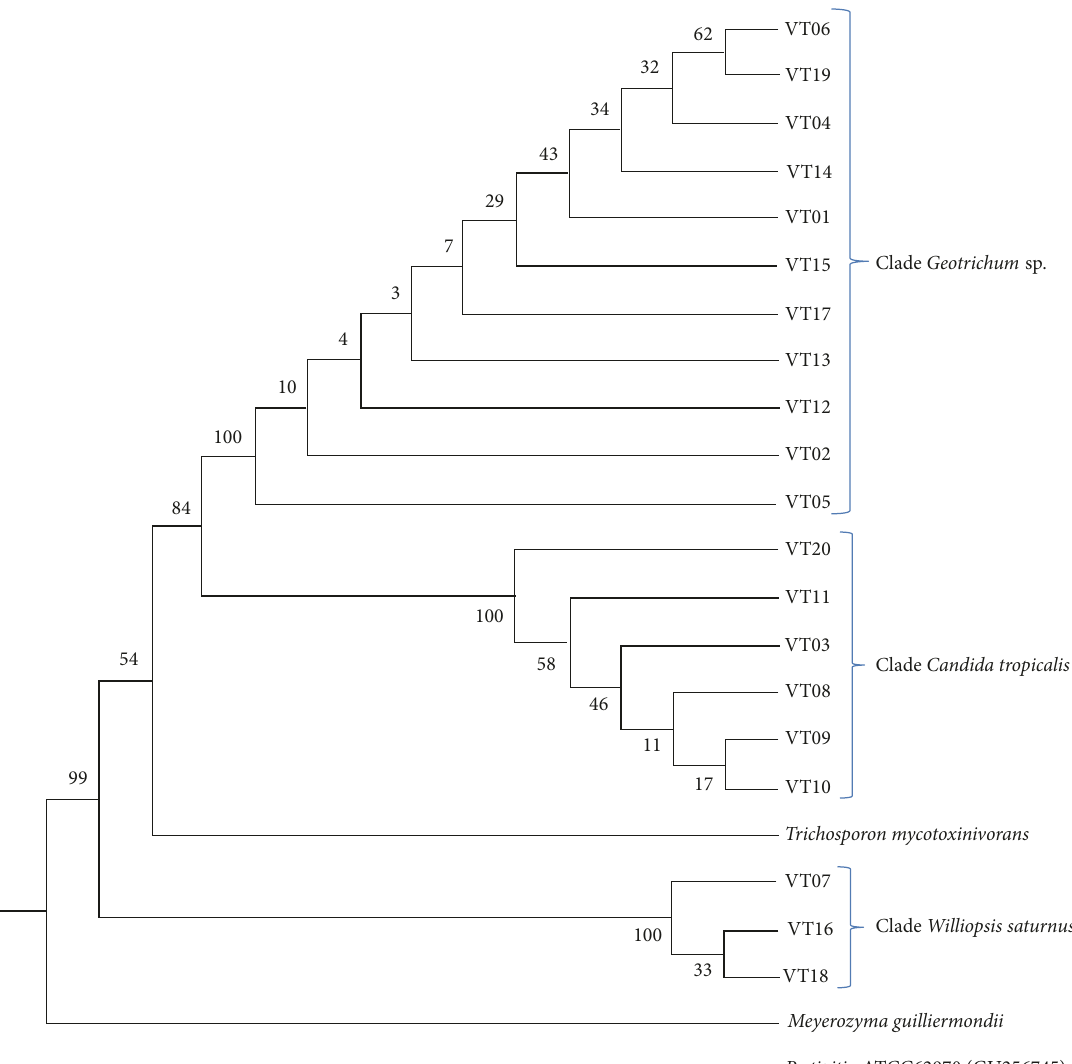
Figure 1: Neighbour-joining phylogenetic tree, endorsing the distribution of the isolates into three